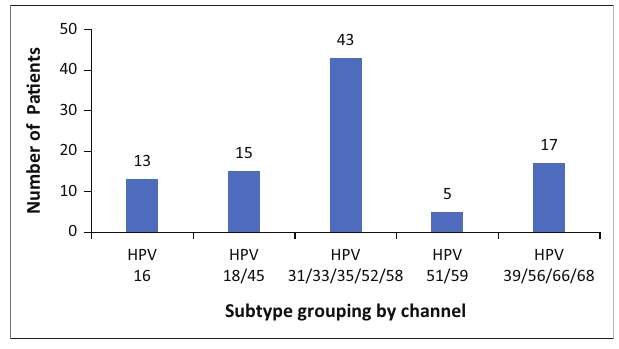
FIGURE 1: Distribution of high-risk human papillomavirus infection in women living with human immunodeficiency virus ( n = 80) as determined by five channel Xpert ® human papillomavirus.